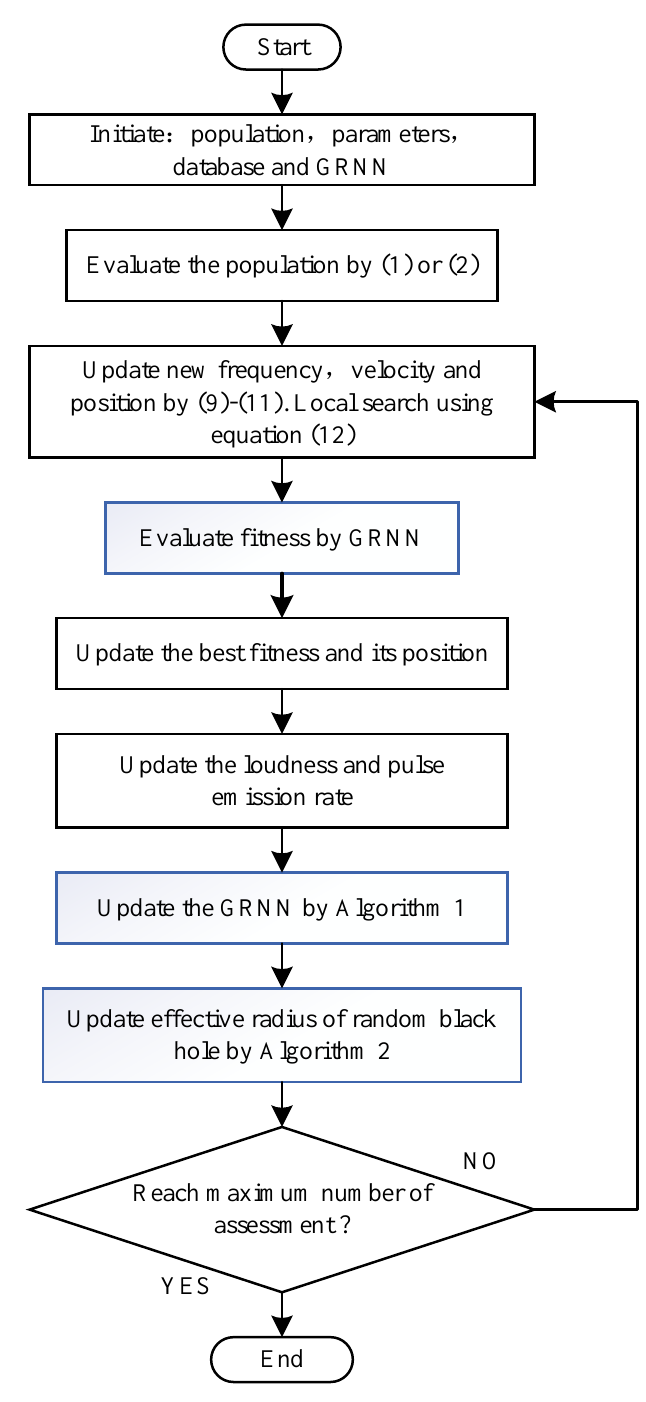
Figure 1. Flowchart of